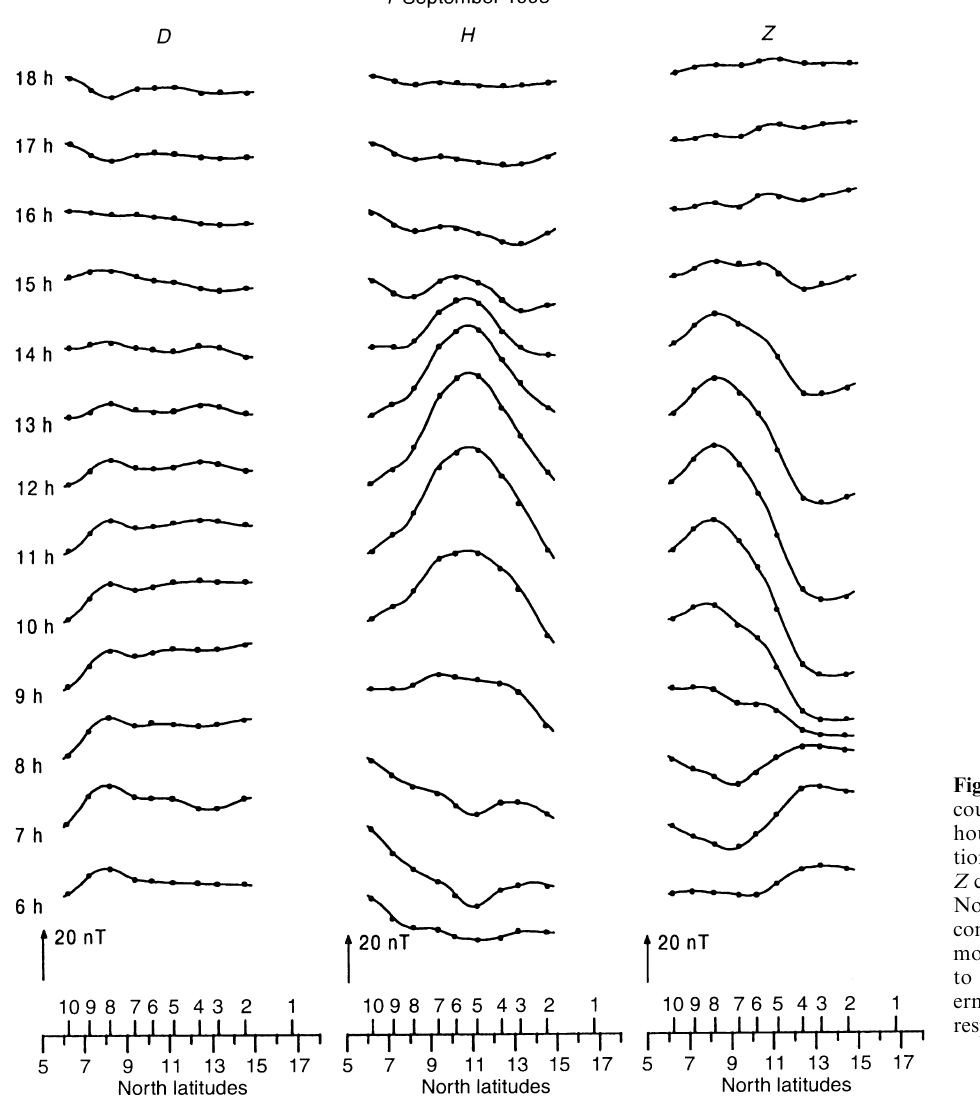
Fig. 9. Example of morning counter-electrojet observed on hourly profiles of the daily varia- tion of the magnetic field D , H , and Z component on 7 September 1993. Notice that the profiles of H and Z components are reversed in the morning (06 h to 08 h). Numbers 1 to 10 on the x -axis refer to north- ernmost to southernmost